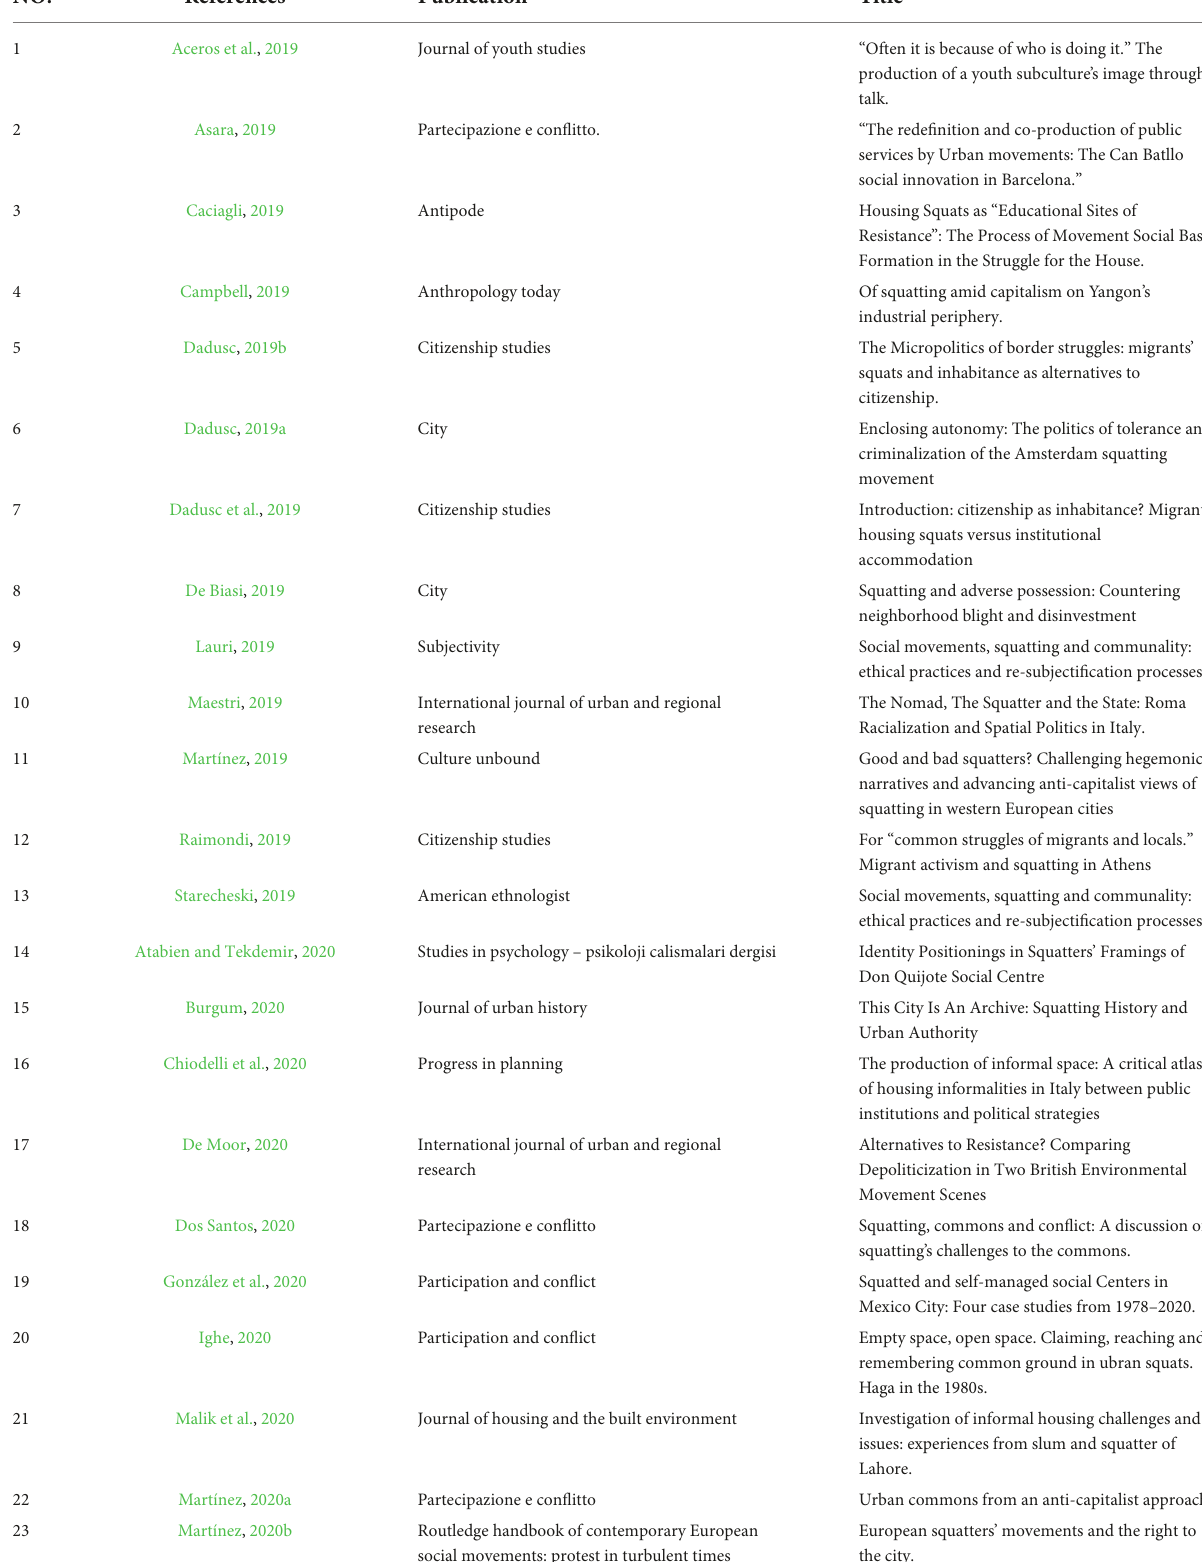
TABLE 2 Articles included in the